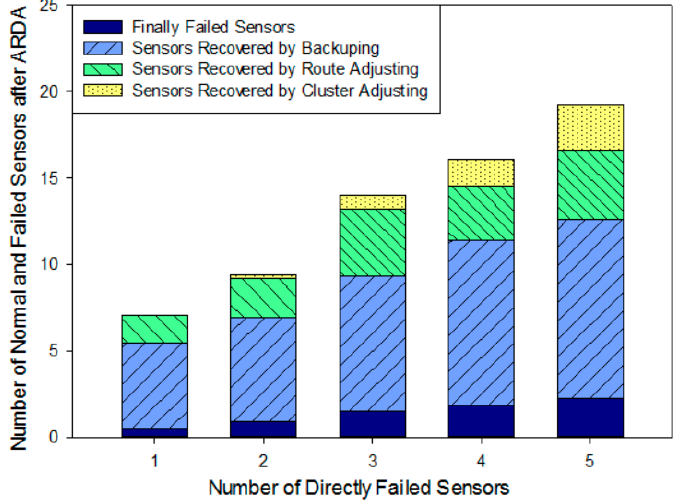
Figure 17. Number of normal and failed sensors after applying ARDA versus the number of physically failed sensors. failed